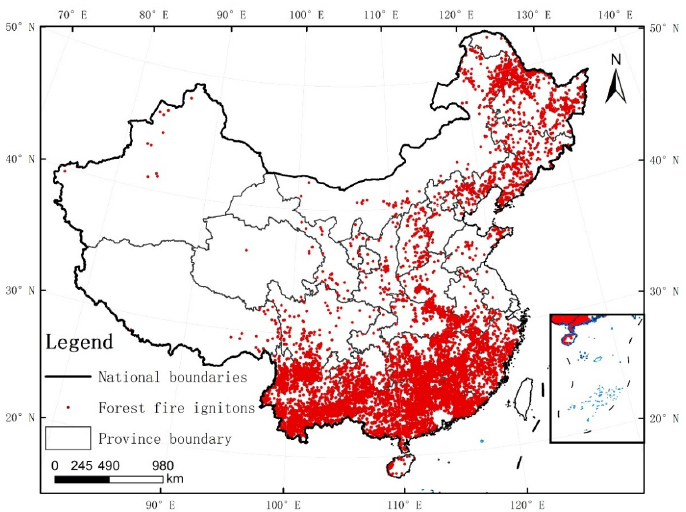
Figure 1. S tudy area (map) and locations of forest fire (FF) ignitions from NASA’s Fire Information for Resource Management System (https://earthdata.nasa.gov/firms , accessed on 1 January